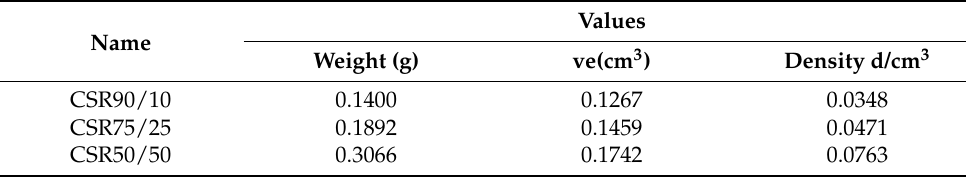
Table 2. Volume and density of CS/R aerogels .